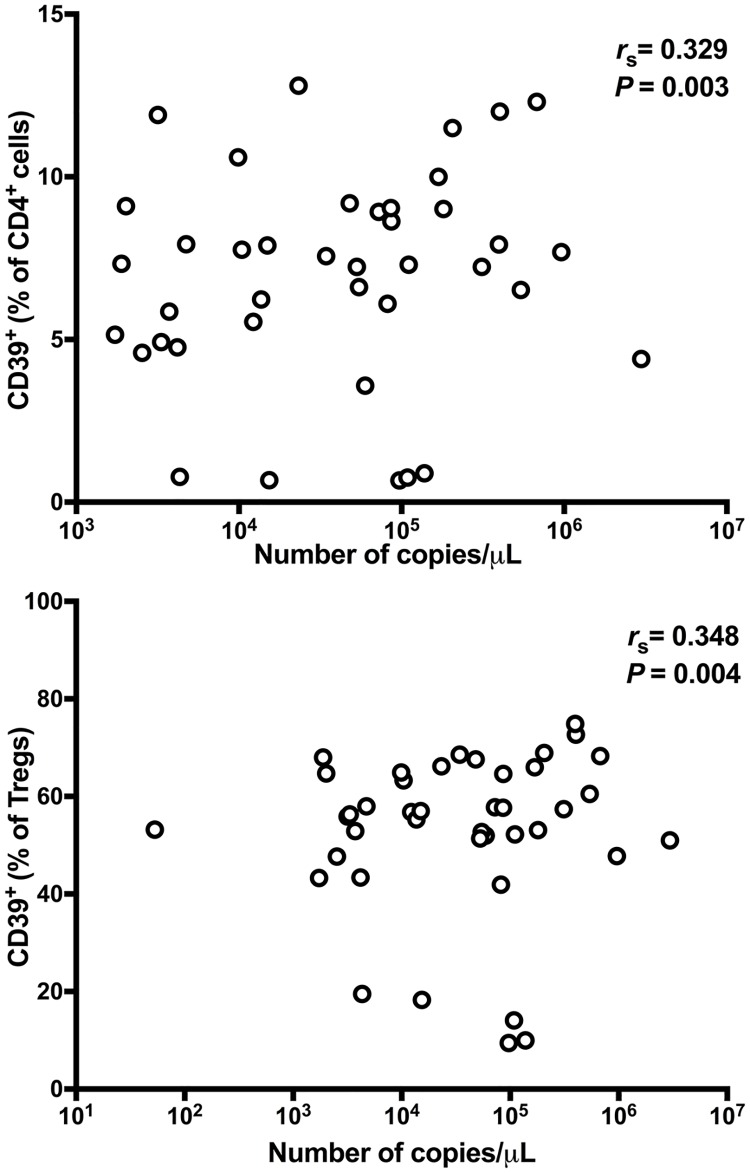
The expansion of CD4+CD39+ T-cell populations in microfilaremics is directly proportional to their microfilarial load.The frequencies of CD4+CD39+ T cells (% of all CD4+ T cells that express CD39; upper panel) and CD39+ Treg cells (% of all CD4+CD25hiCD127-FoxP3+ T cells that express CD39; lower panel) were plotted against the number of Mansonella ozzardi-specific ITS-2 amplicon copies obtained by quantitative real-time PCR, a proxy of microfilarial load. Data analyzed for 48 subjects using the Spearman rank correlation test.